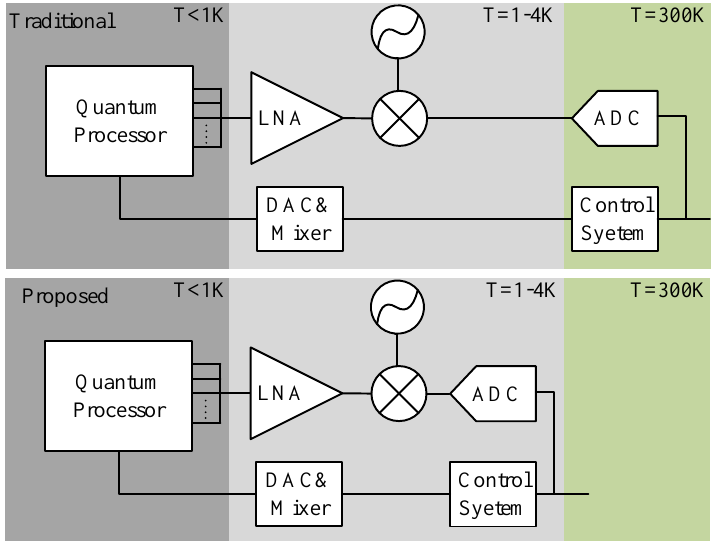
Figure 1. The traditional quantum processor control system and proposed cryogenic control